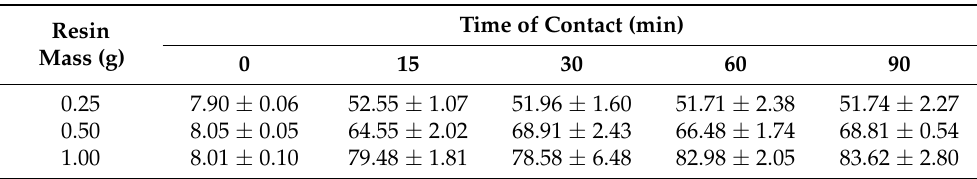
Table 4. Purification ratios (%) obtained for Bio-Rad 50W-X8 100–200 mesh (results correspond to the average of three replicates ± standard deviation).